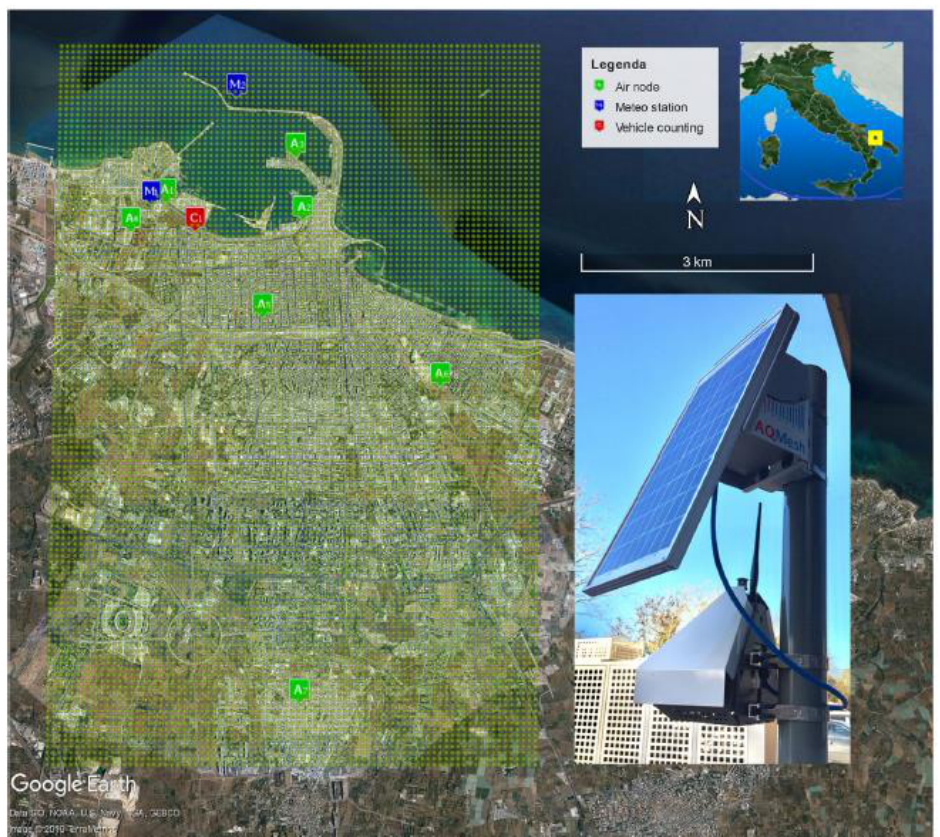
Figure 10. Area of analysis reporting the location of monitoring sensors, the position of Bari in Italy (upper right box), and a typical sensor (lower right box). Reprinted with permission from ref. [45].